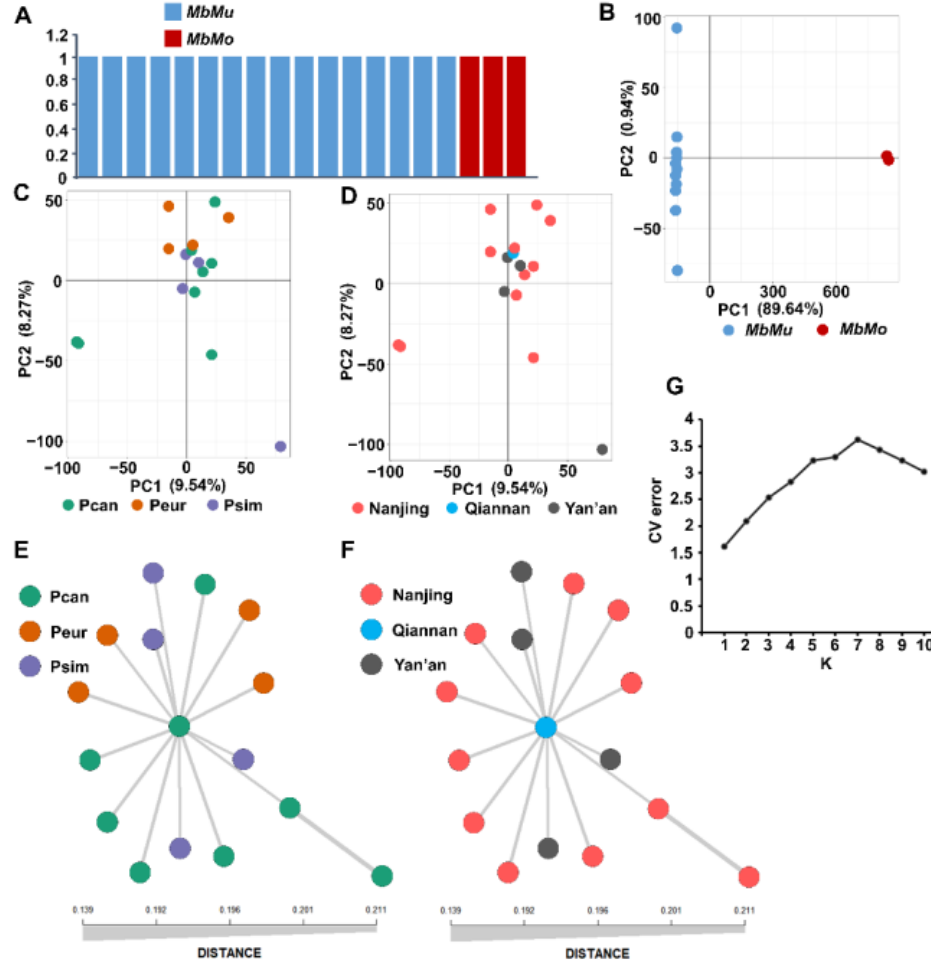
Figure 2. Population structure analysis of M . brunnea isolates. ( A ) Structure plot inferred by fast- STRUCTURE with the SNP dataset of 19 nonredundant M . brunnea isolates. K = 2. y-axis quantifies cluster memberships. ( B ) PCA of 19 nonredundant M . brunnea isolates. ( C , D ) PCA of 16 nonredun- dant MbMu isolates. The color of the circle corresponds to the hosts ( C ) and sampling locations ( D ). ( E , F ) MSN plots of 16 nonredundant MbMu isolates. The color of the circle corresponds to the hosts ( E ) and sampling locations ( F ). ( G ) Cross-validation (CV) error (y-axis) for K between 1 and 10. The estimation was generated by ADMIXTURE